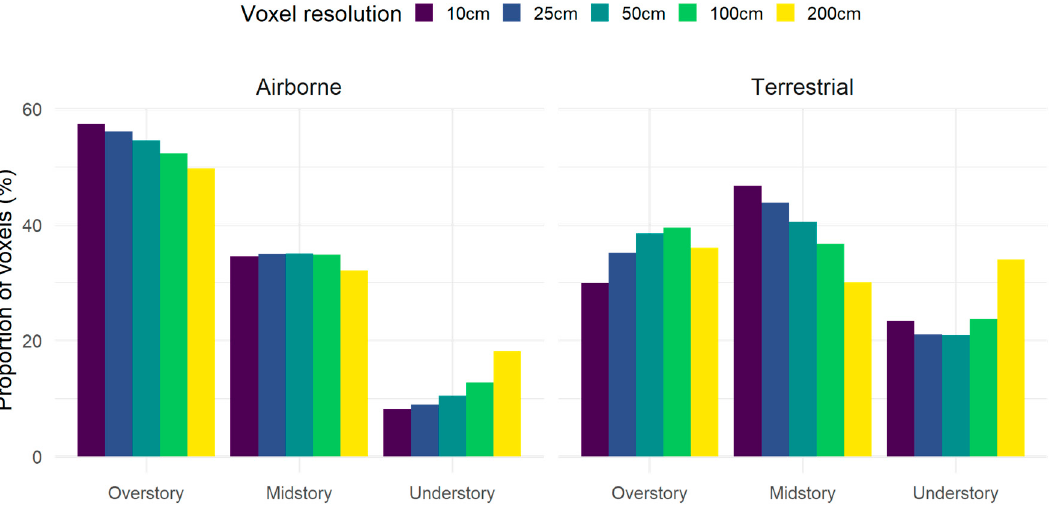
Figure 5. The proportion of voxels as a function of forest stratum. The understory and overstory respectively correspond to ≤ 10 m and ≥ 20 m height intervals.